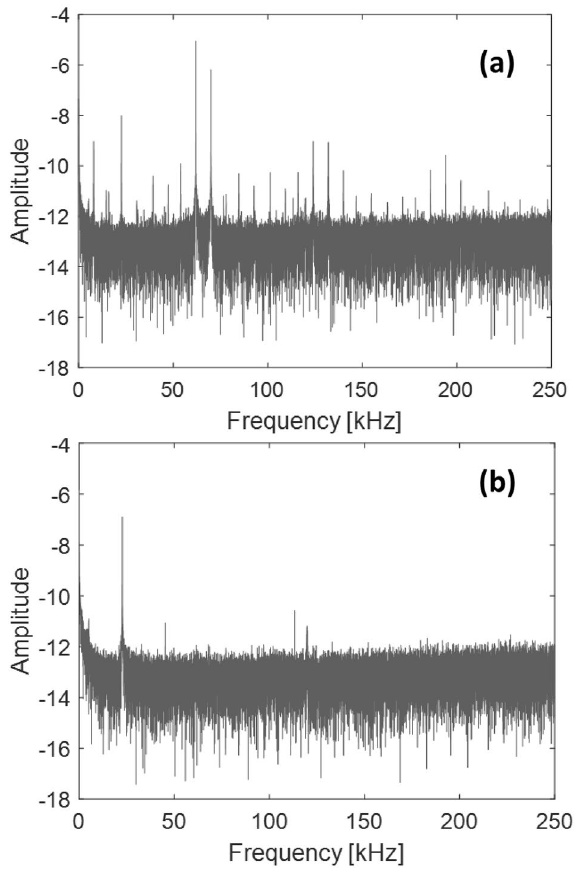
Figure 2. Fourier frequency Spectrum calculated from velocity time series measured using a laser Doppler vibrometer on third rod of the array of waveguides ( a ) and on the corresponding rubber band ( b ). The amplitudes are in dB. The 22 kHz peak in ( b ) is an artifact from the laser Doppler